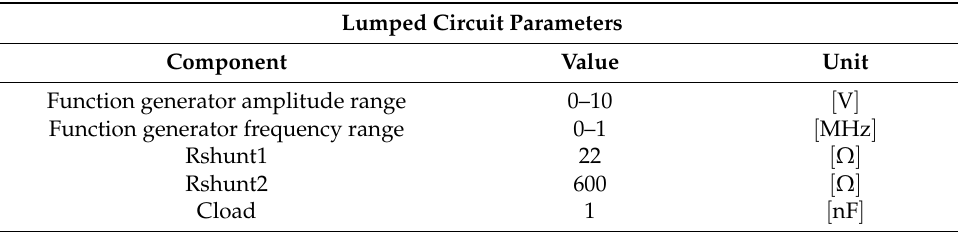
( b ) Figure 11. ( a ) Side A of the controlled gap mover apparatus; ( b ) side B of the controlled gap mover 483 apparatus. 484